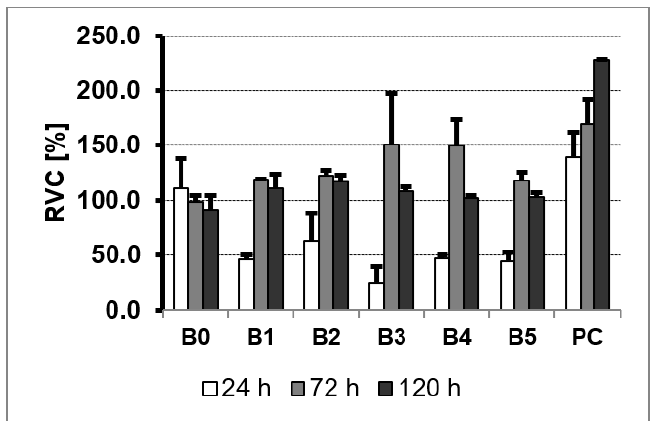
Figure 10. The results of the MTS assays performed at 24, 72, and 120 h on the viability of the NHost: ultrafine-grained Ti23Zr25Nb alloy (B0), ultrafine-grained Ti23Zr25Nb alloy electrochemically modified (B1) and Ti23Zr25Nb—9 wt.% 45S5 Bioglass (B2), Ti23Zr25Nb—9 wt.% 45S5 Bioglass—1 wt.% Ag (B3), Ti23Zr25Nb—9 wt.% 45S5 Bioglass—1 wt.% Cu (B4), Ti23Zr25Nb—9 wt.% 45S5